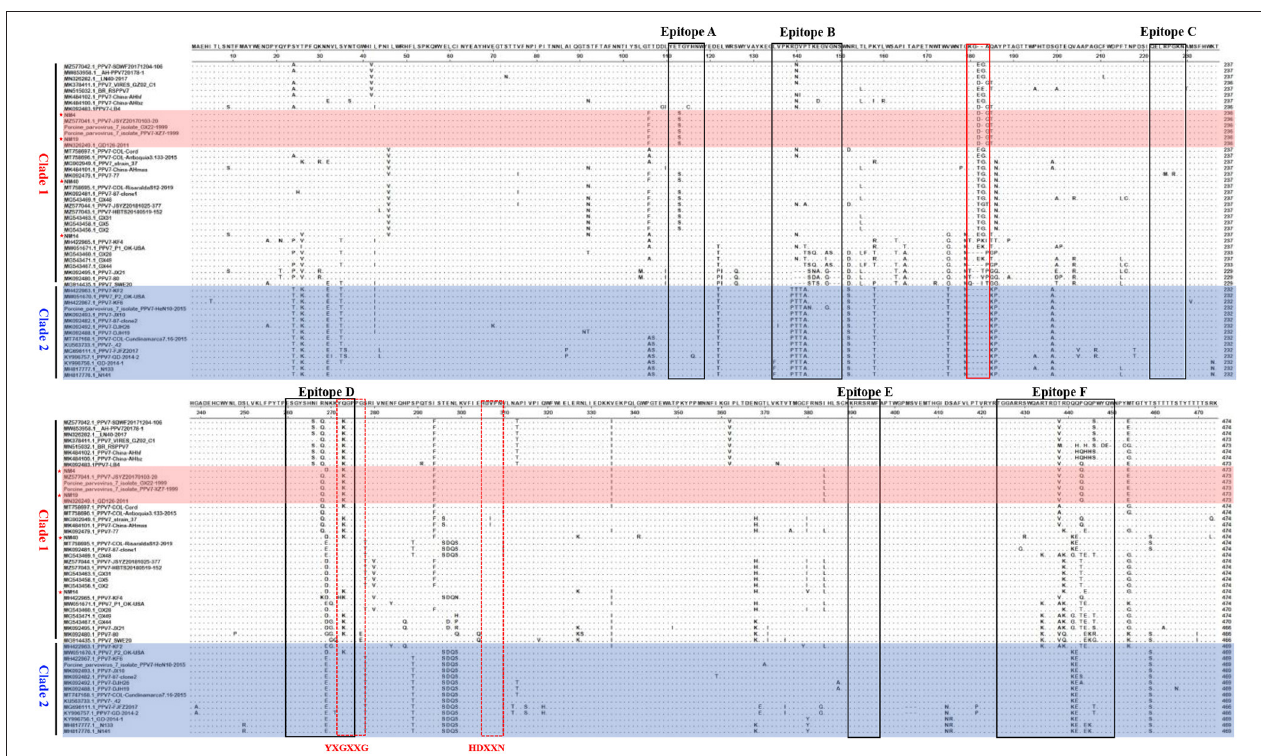
FIGURE 6 | Alignment of Capsid amino acid sequences of PPV7 strains. The 6 linear B cell epitope regions (Epitope A ∼ E) of PPV7 Capsid were marked with black box. The five-amino-acid deletion of PPV7 strains clustered in clade 2 was marked with a red solid box. The conserved amino acids of the Ca2 + binding loop (YXGXXG) and the catalytic residue (HDXXY) are marked with a red dotted box.